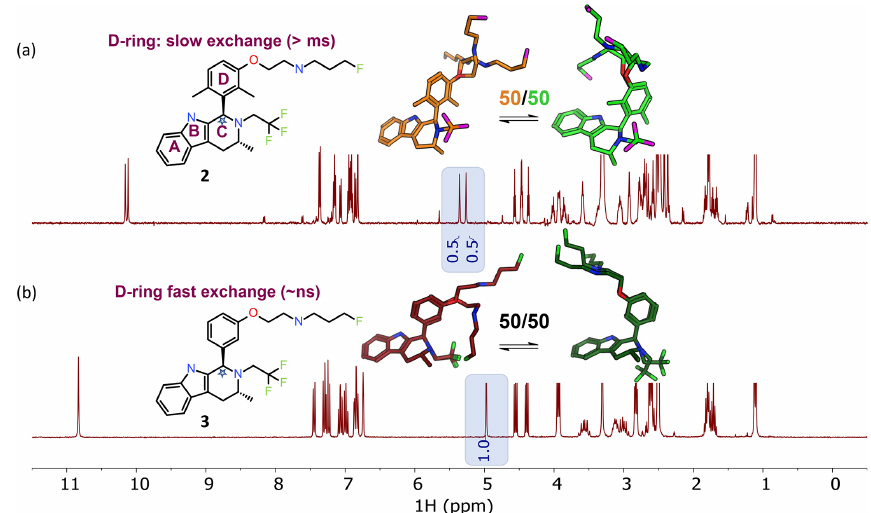
Figure 2. NMR spectra inherently capture kinetic information from conformational dynamics (rotational energy barriers) in the signal line widths. The benzylic CH (the starred CH in ring “C”) is highlighted to exemplify the spectral changes between the dimethyl and des-methyl analogs. (a) The 1 H NMR spectrum shows rotamers with equal populations undergoing slow exchange on the NMR timescale. Profiling of compound 2 gave pIC 50 8.9 and logD 4.8, with 50% bioactive conformation of the free ligand in DMSO- d 6 solution. (b) A spectrum with population-weighted conformational averaging due to low barriers to rotation around bonds and fast exchange on the NMR timescale. Profiling of 3 resulted in pIC 50 8.8, logD 4.1, 50% free ligand solution bioactive conformation. For this molecular matched pair we see similarities in the percent bioactive conformation in solution and the potency, regardless of the increased logD.